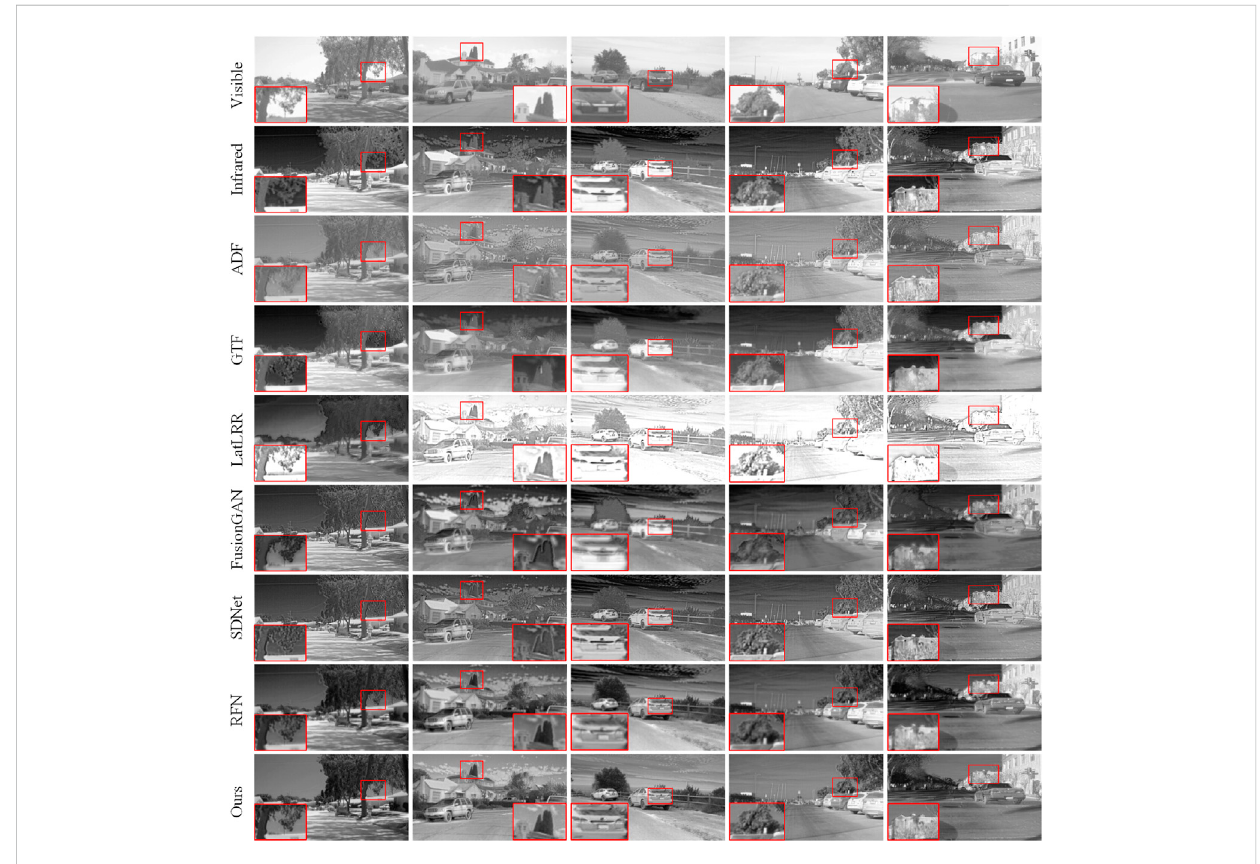
FIGURE 6 Fusion results of different methods on fi ve pairs of images from RoadScence.